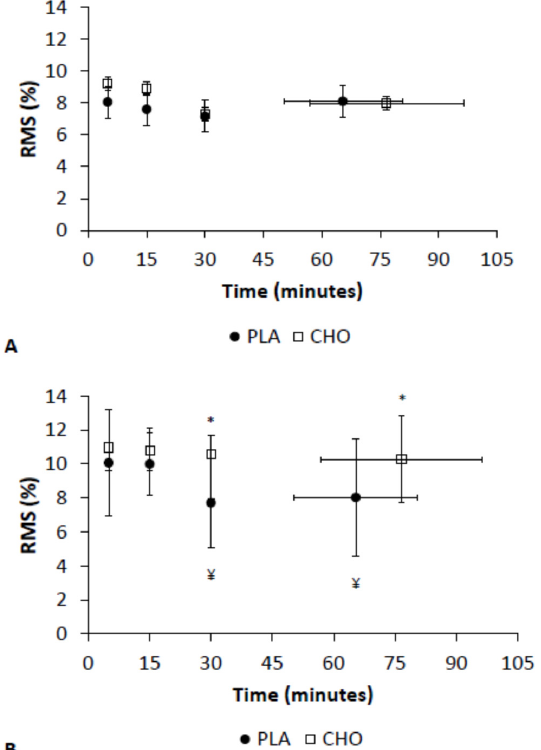
Figure 4. EMG activity during moderate ‐ intensity exercise in ( A ) rectus femoris (RF); and ( B ) vastus lateralis (VL). * Different from PLA, p < 0.01. ¥ Different from time 0 and 15 for placebo only, p < 0.03.